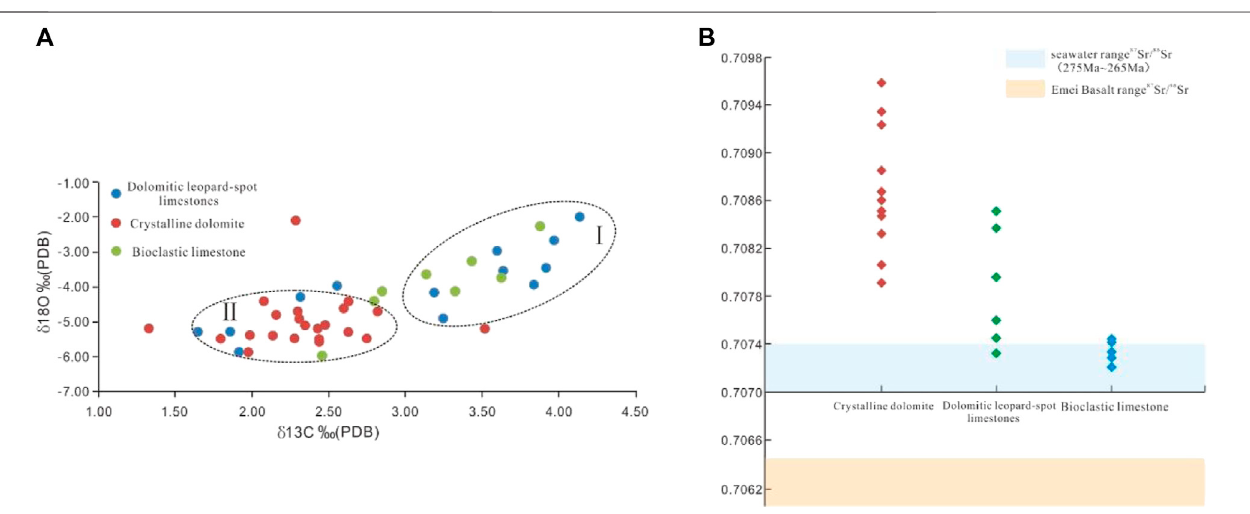
FIGURE3| C,O,andSrisotopecharacteristicsofcarbonatesintheQixiaFormationinthestudyarea. (A) CandOisotopedistributionpatternsofcarbonatesinthe Qixia Formation; I-crystalline dolomite clustering; II-dolomitic “ leopard-spot ” and base limestone clustering. (B) Sr isotope distribution of carbonate in the Qixia